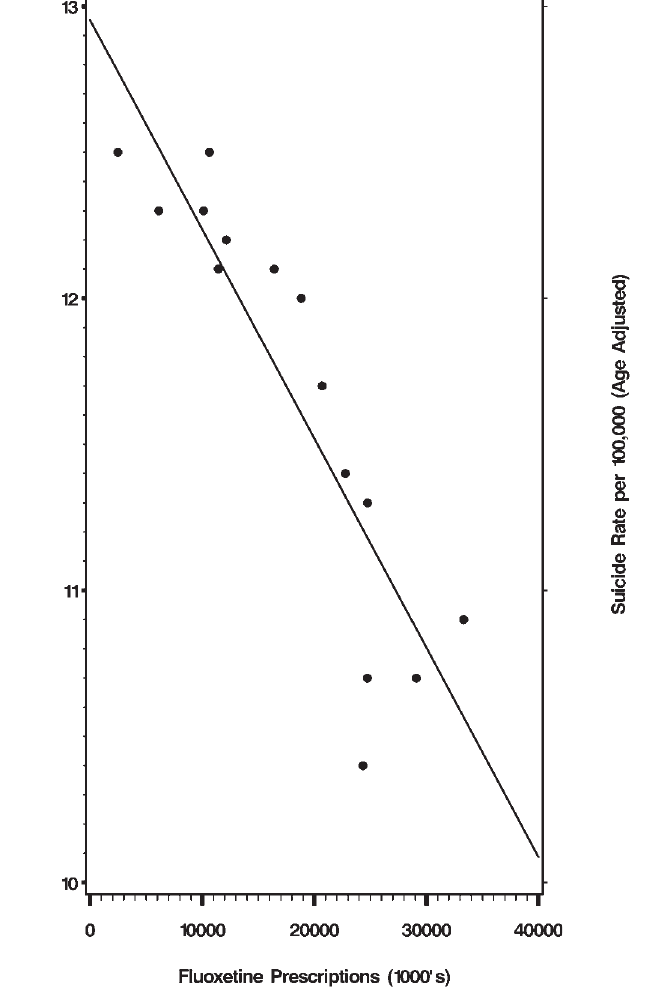
doi:10.1371/journal.pmed.0030501.g002 Figure 2. Correlation between Suicide Rates and the Dow Jones